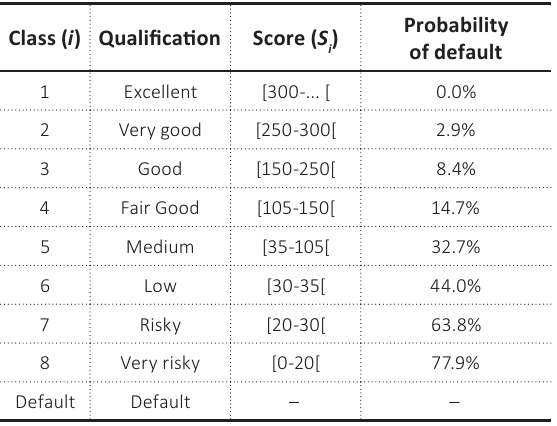
Table 8. Conception of the rating